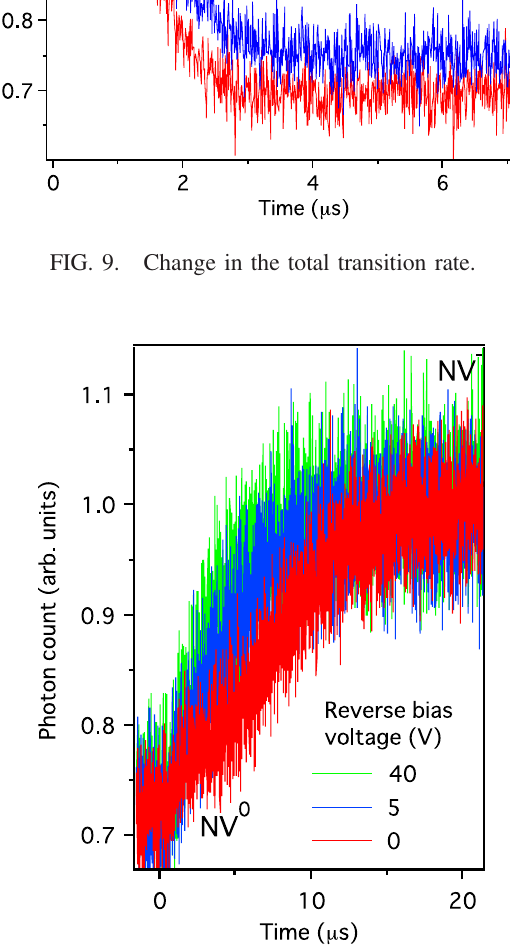
FIG. 8. Photon accumulation measurements of varying current values below the 0.4-mW laser irradiation.